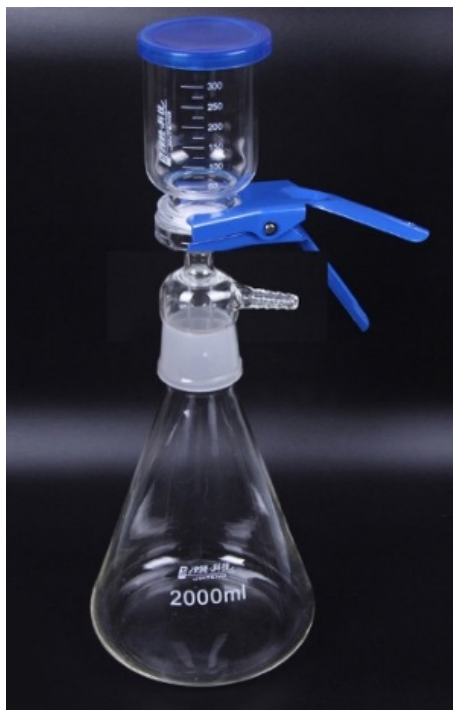
Figure 2. Sand core suction filter device.